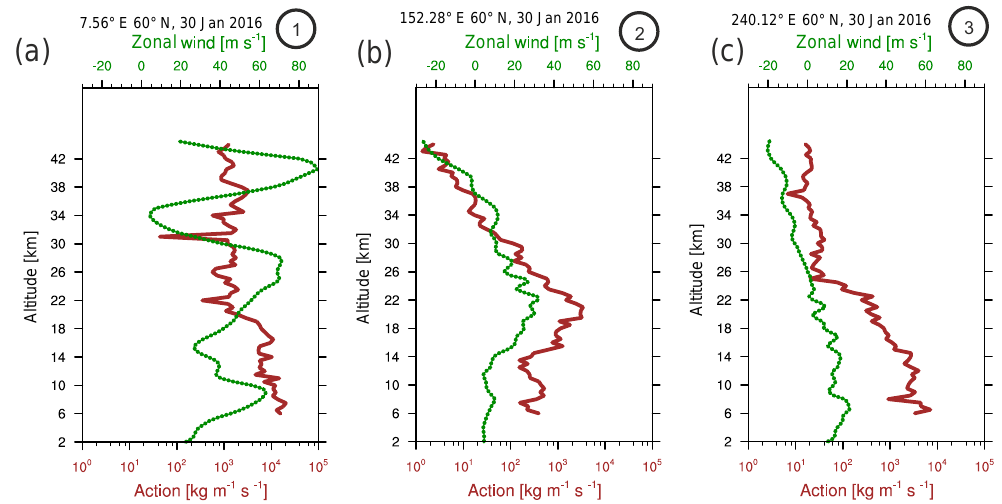
Figure 5. Vertical profiles at 60 ◦ N on 30 January 2016. Local vertical profiles at 7.56 ◦ E (a) , 151.92 ◦ E (b) , and 240.12 ◦ E (c) with the wave action (solid, red) and zonal wind (dashed, green). Local profiles according to markers in Fig. 4.